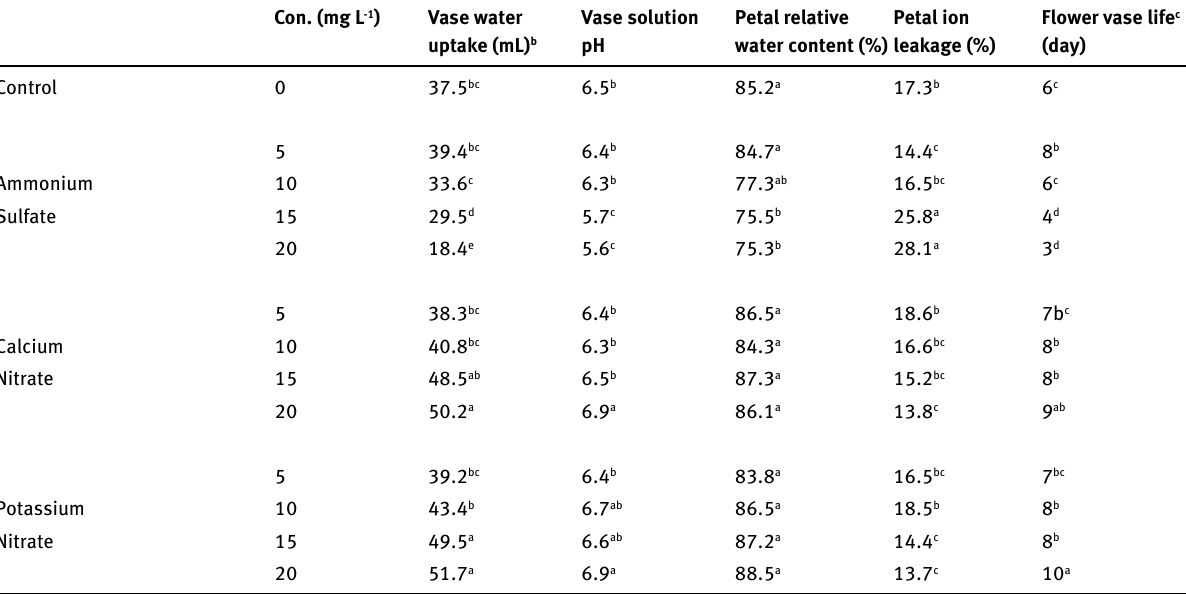
Table 2: Changes in some other parameters of cut rose flowers affected by different concentrations of ammonium or nitrate forms in holding solution. In each column comparison of means was done at 5% Duncan test